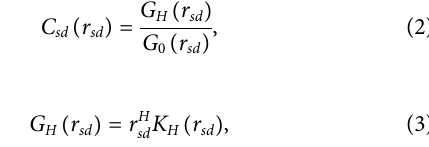
Frontiers in Earth Science |